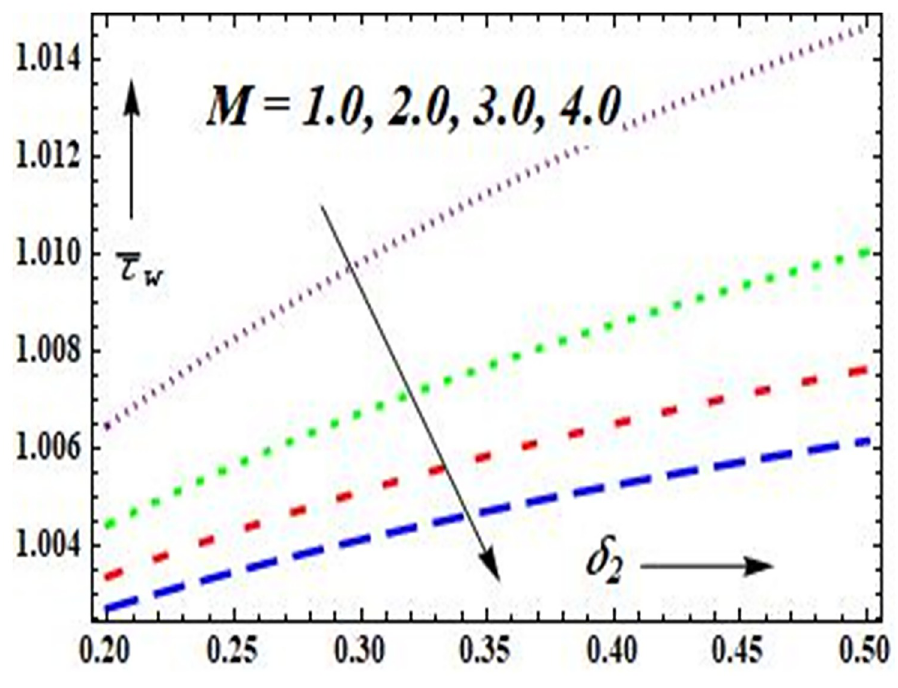
Fig 13. Plot of � τ